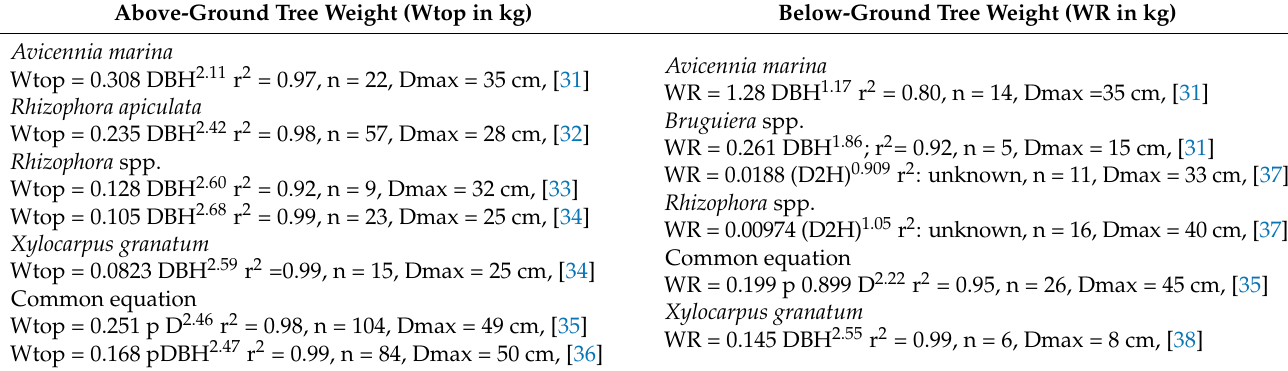
Table 1. Allometric equations for calculating mangrove tree biomass used in this study [30]. Above-Ground Tree Weight (Wtop in kg) Below-Ground Tree Weight (WR in kg) Avicennia marina